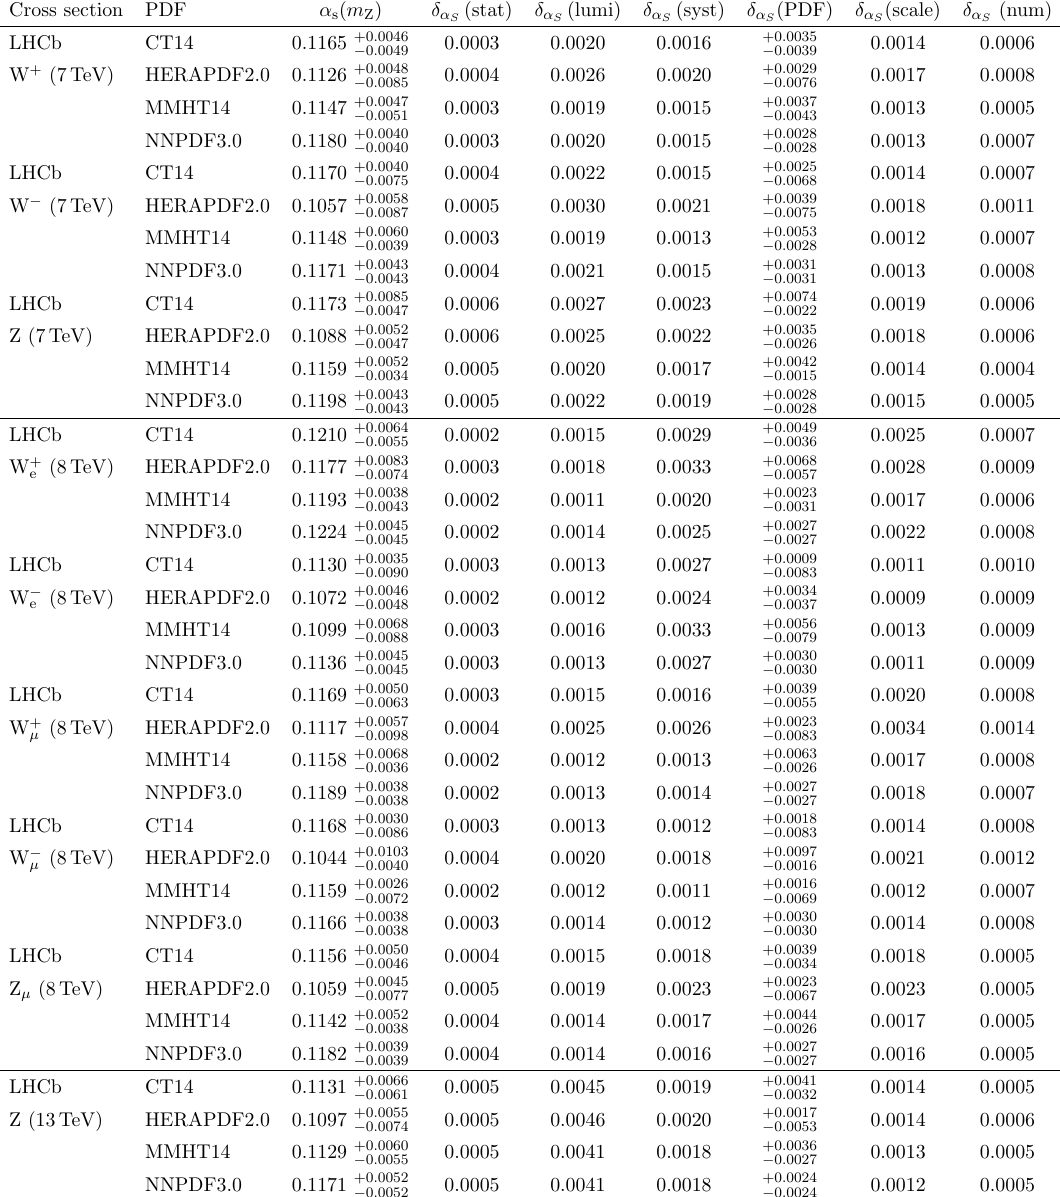
Table 16 . Extracted (cid:11) s ( m Z ) values from the comparison of the W + , W (cid:0) , and Z boson production cross sections measured by LHCb to NNLO pQCD predictions. For each measurement, four results are extracted, one per PDF set. The breakdown of the propagated uncertainties from di(cid:11)erent ex- perimental (statistical, integrated luminosity, and systematic including c.m. energy) and theoretical (PDF, scale, and numerical) sources is provided for each (cid:11) s ( m Z )